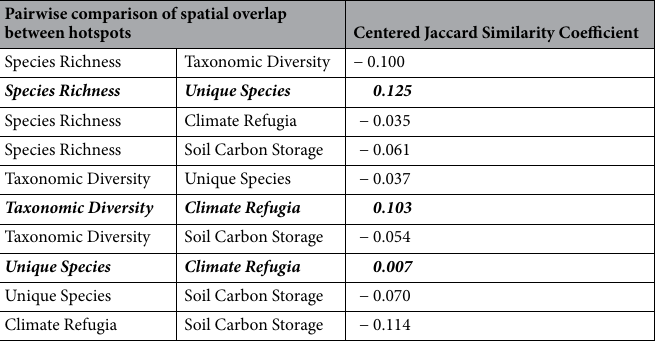
Table 2. Pairwise comparison of overlap between hotspots across the boreal caribou distribution. Comparisons in bold italics identify areas that overlap more than expected by random (positive Centered Jaccard Similarity